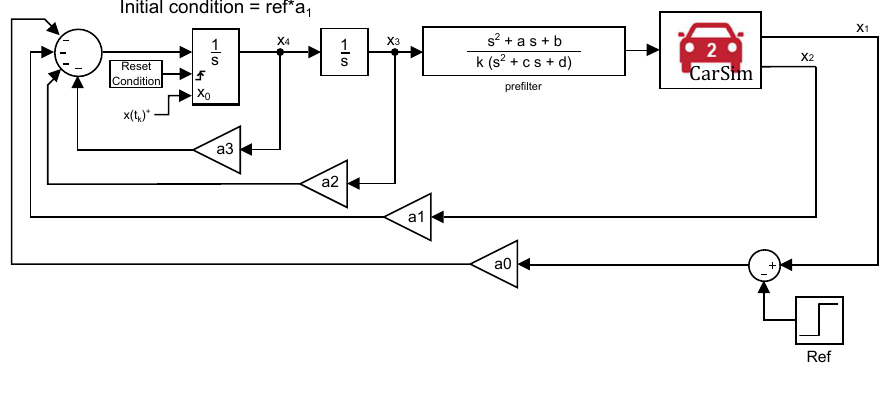
Figure 27. System used for validation.